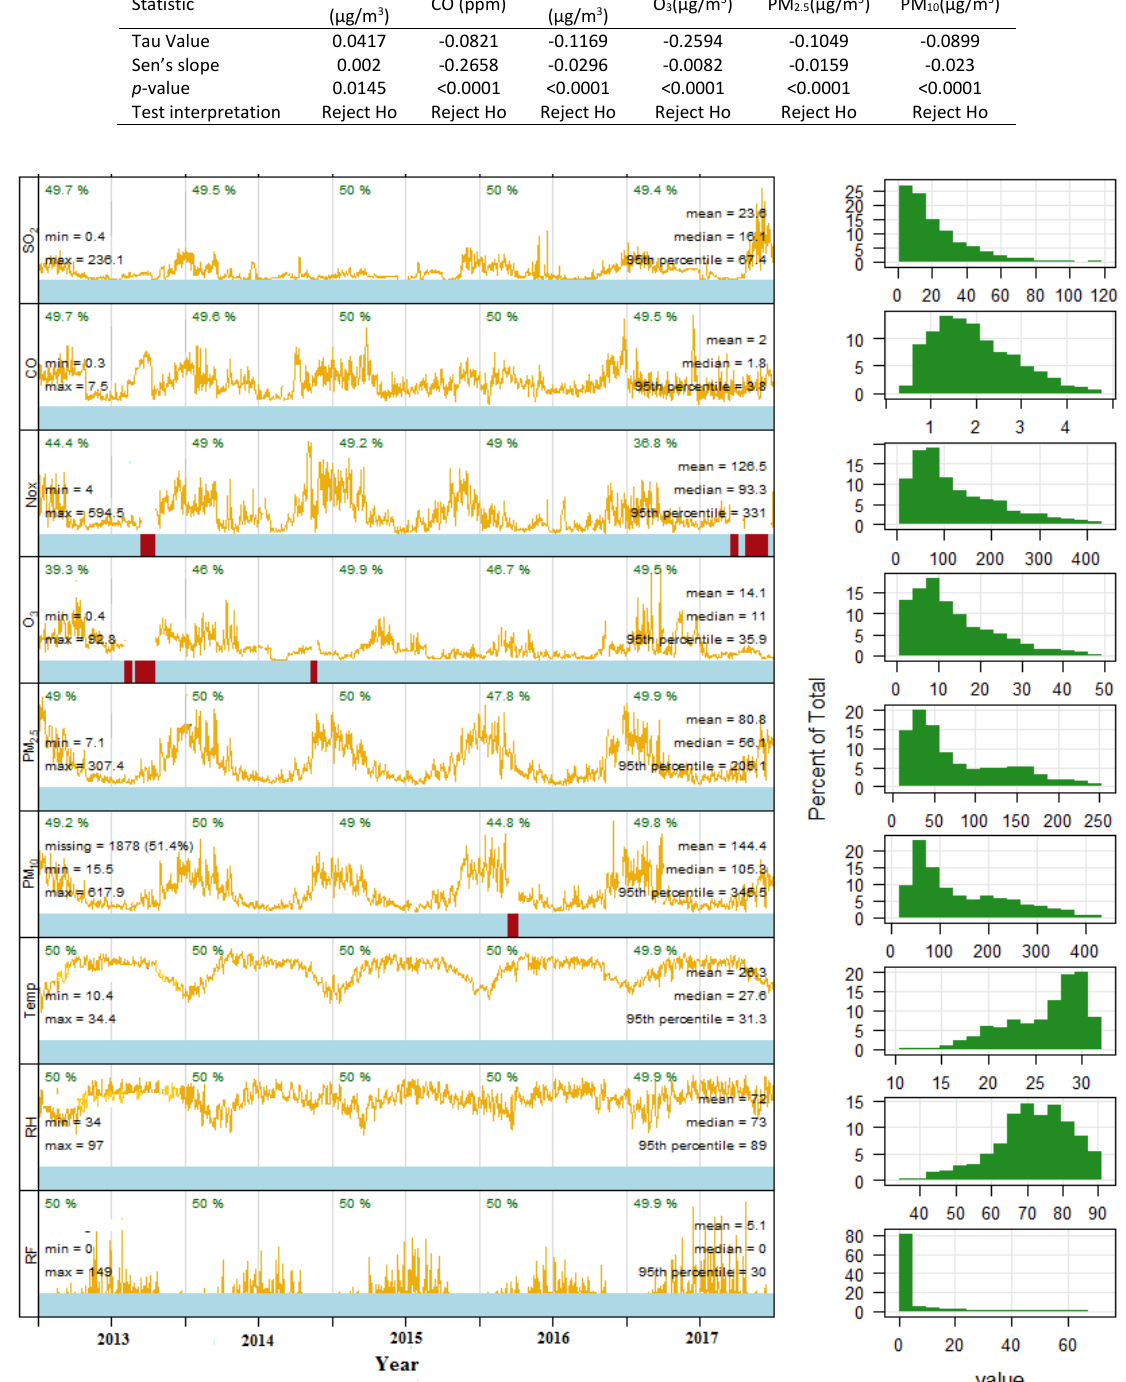
Fig. 2: Trends of air pollutants concentration and meteorological parameters from January 2013 to December 2017 in Dhaka